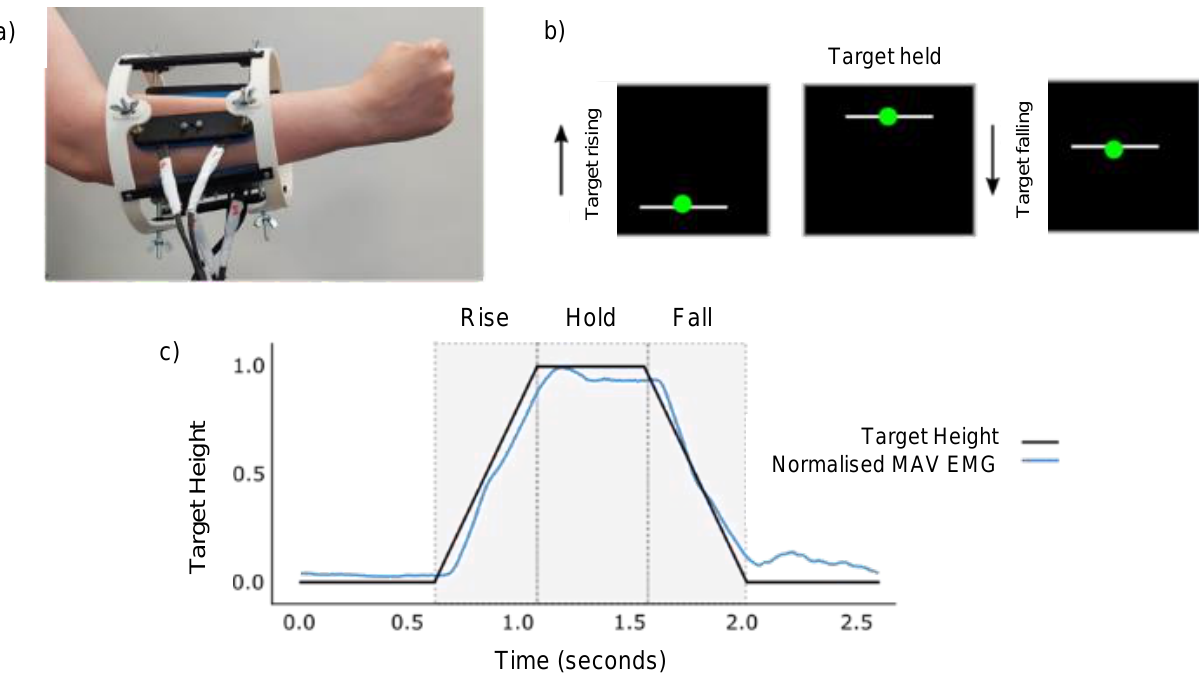
Figure 3: a) A photo of the compression simulator being worn. Note the limb is extended more than the 90° than described in the text to obtain a clear picture. b) An example of what the task looked like on screen as presented to the participants. The white line is the moving target, and the green ball is the cursor which participants control with their EMG activity. c) An example plots from a high-target task with the corresponding EMG activity showing the participant tracking the height of the cursor. Only the three gray areas highlighted in the graph were used to calculate participant scores, corresponding to the rise, the hold period, and fall of the on-screen